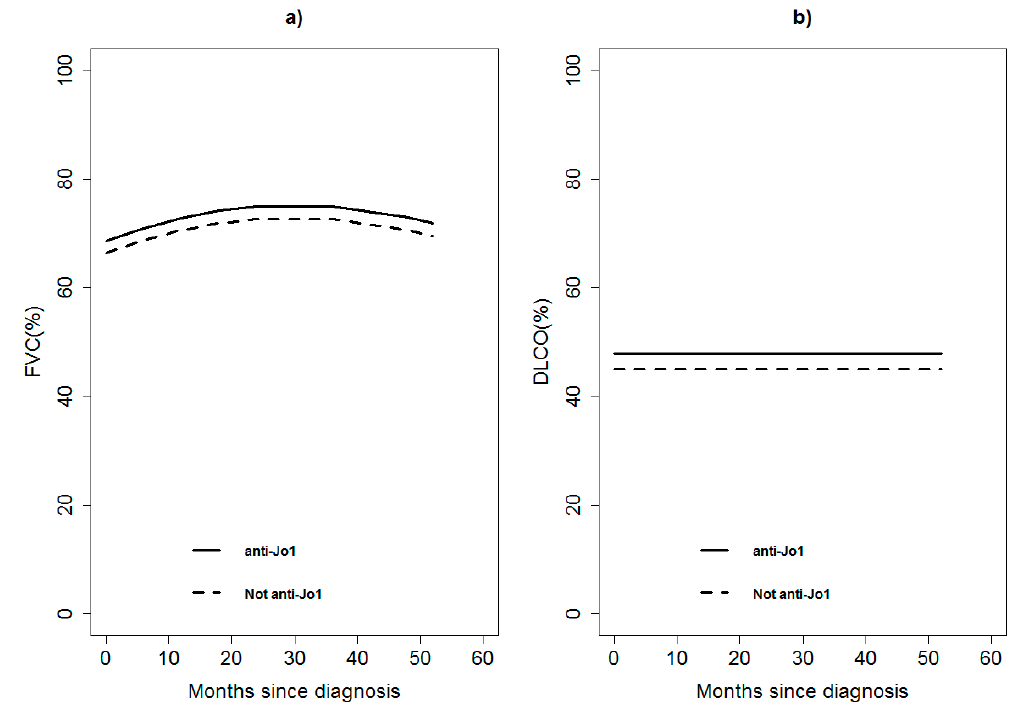
Figure 1. Model-based predicted value of forced vital capacity (FVC, panel a ) and carbon monoxide diffusion capacity (DLCO, panel b ) by time and anti-Jo1 for a patient 60 years old, anti-SSA/Ro52+ negative, acute onset, diagnosis within 12 months from symptom onset, and without immunosuppressant treatment. A continuous line represents anti-Jo1 patients; dashed lines represent non anti-Jo1 patients.